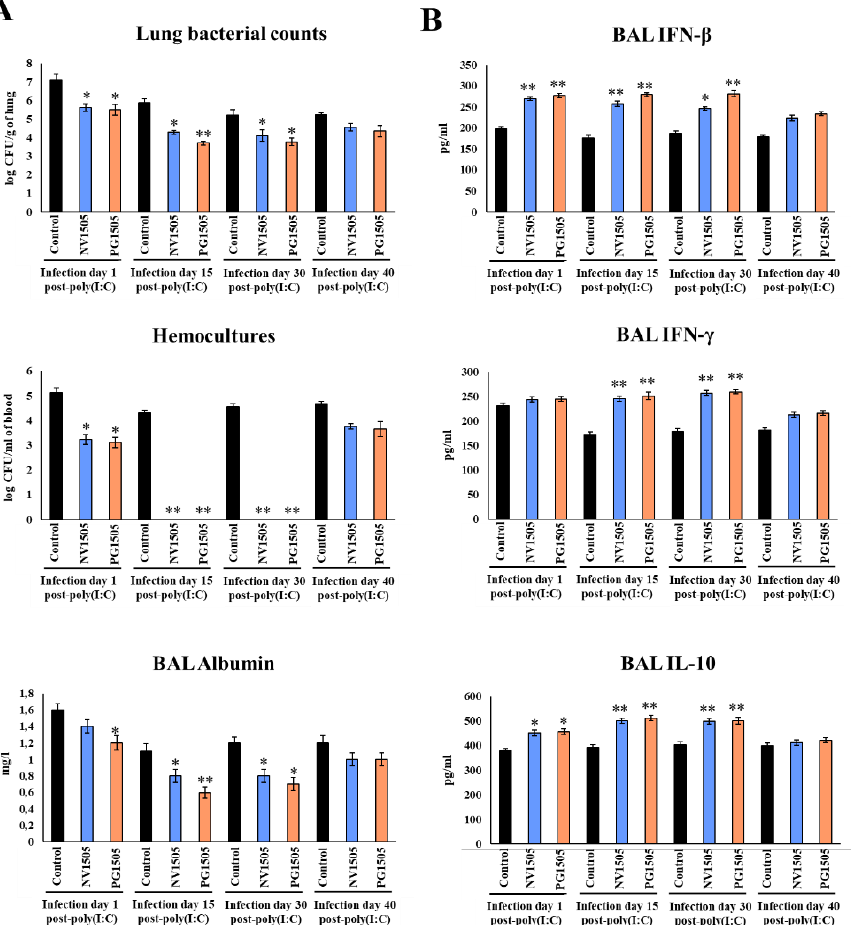
Figure 6. Ability of non-viable L. rhamnosus CRL1505 (NV) and its peptidoglycan (PG) to enhance resistance to secondary pneumococcal pneumonia after poly(I:C) treatment over time. Infant mice were nasally primed with NV1505 or PG1505 for two consecutive days. They were stimulated with three once-daily doses of poly(I:C) and finally challenged with S. pneumoniae on days 1, 15, 30 and 40 after the last poly(I:C) administration. ( A ) Lung bacterial cells counts, hemocultures and albumin concentrations in bronchoalveolar lavages (BAL) as well as ( B ) the levels of interferon (IFN)- β , IFN- γ and interleukin (IL)-10 in BAL were determined on day 2 post-pneumococcal challenge. The results represent data from three independent experiments. Asterisks indicate significant differences between treated and control groups; * ( p < 0.05) and ** ( p < 0.01).